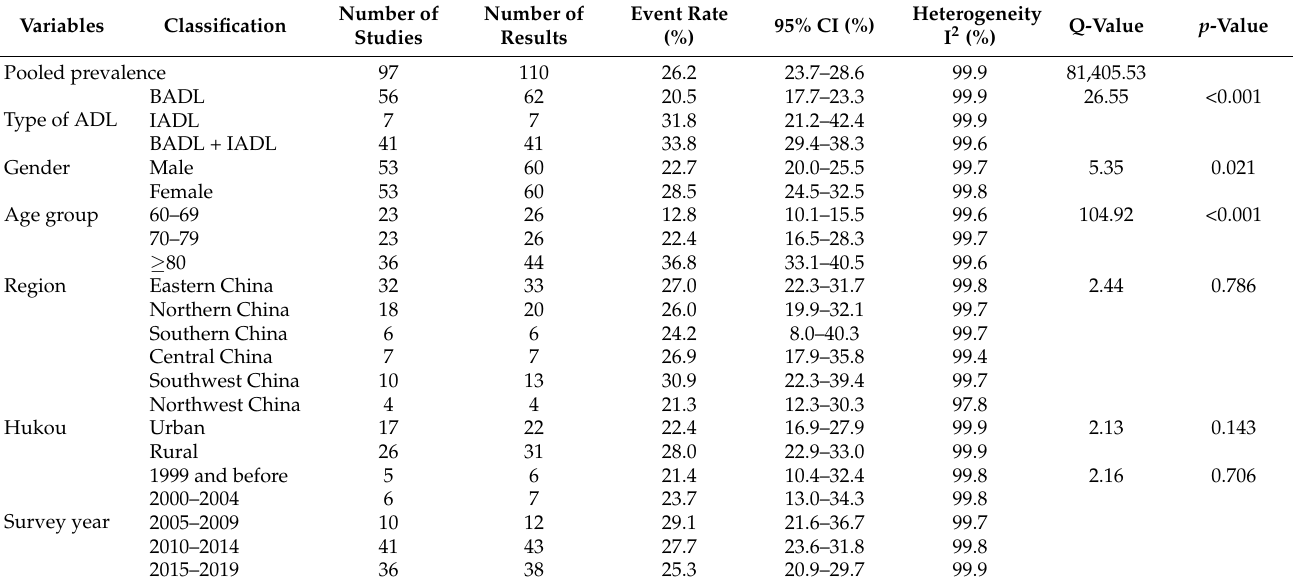
Table 2. Pooled prevalence of disability and subgroup